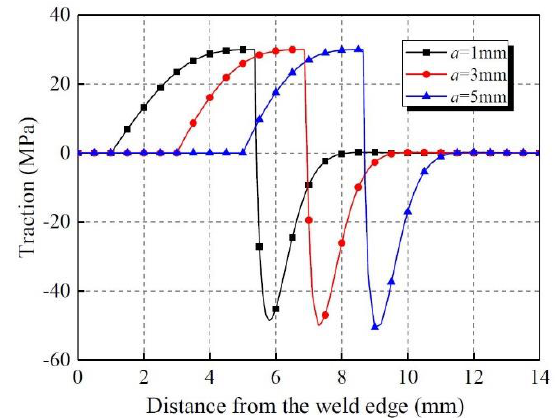
Figure 16. Traction force of the cohesive element along the brazing seam after crack growth.